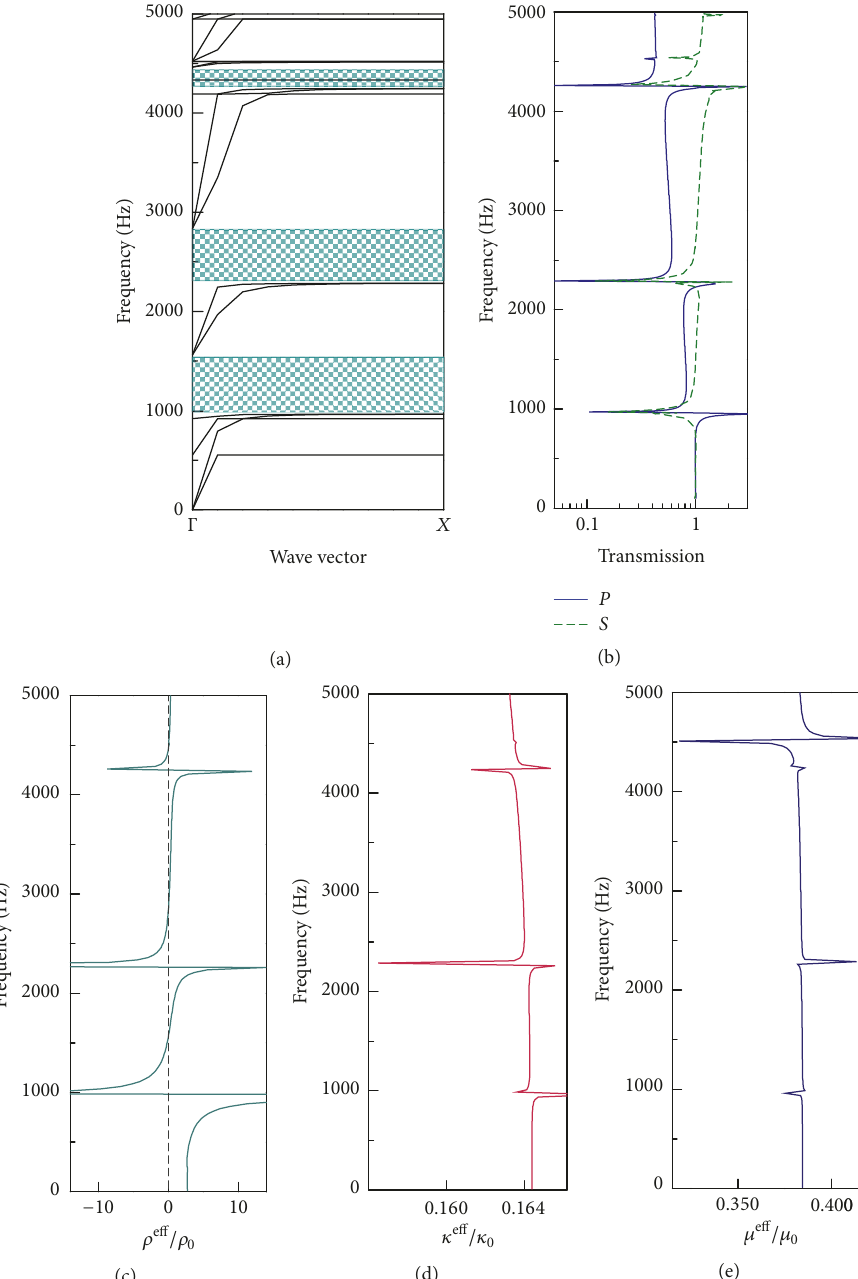
Figure4:Bandstructureofdual-oscillatoracousticmetamaterialinthe Γ𝑋 direction(a);transmissioncharacteristiccurveinthe Γ𝑋 direction (b); normalized effective mass density, effective bulk modulus, and effective shear modulus